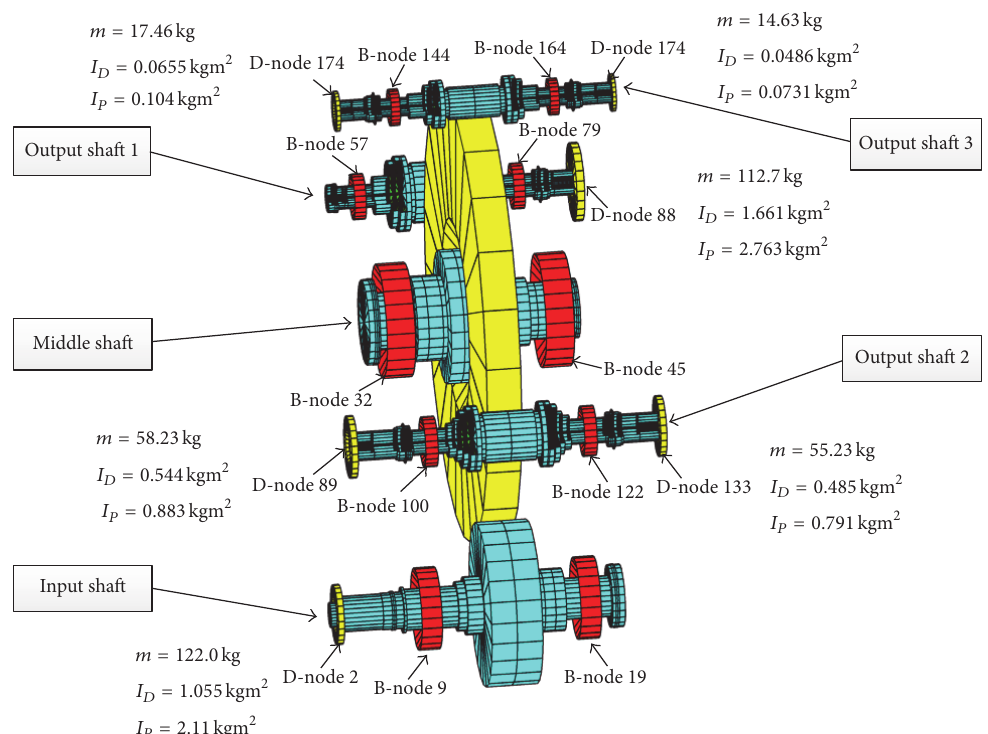
Figure 7: Five-shaft geared rotor-bearing system of integrally geared compressors.